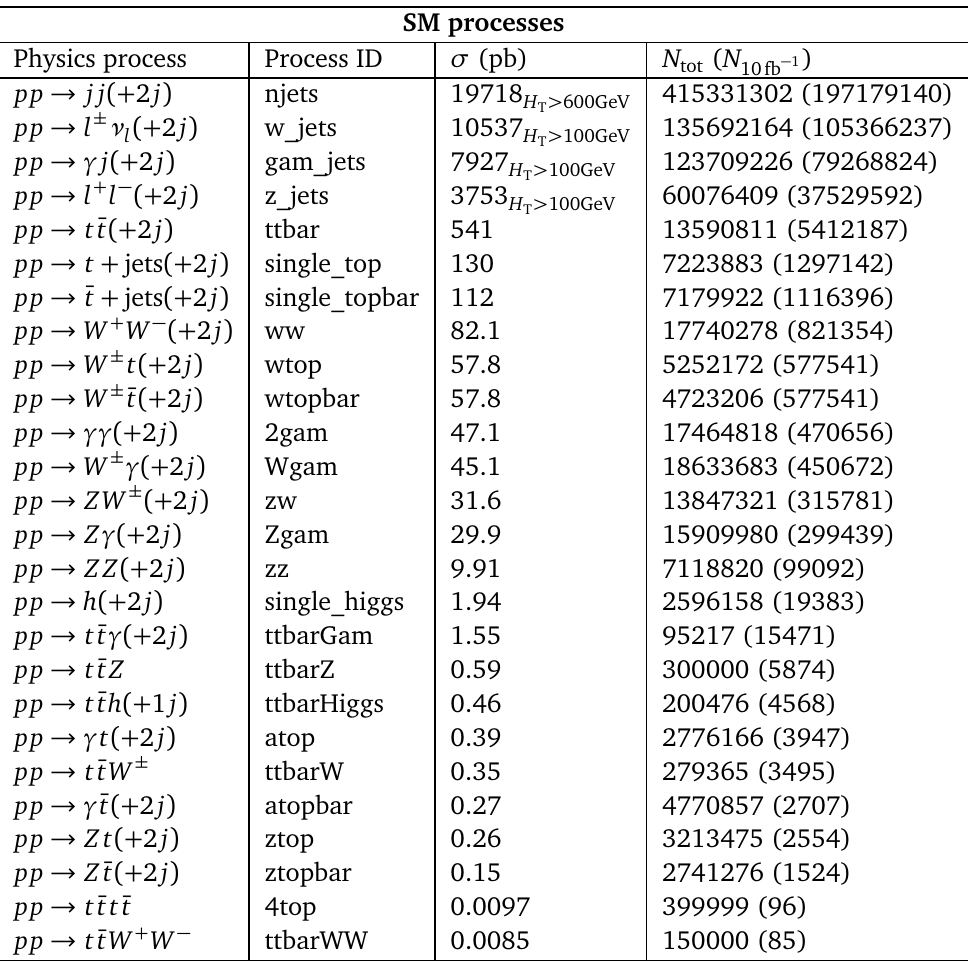
Table 2: Generated background processes (first column) with the corresponding identification (second column), the LO cross section σ in pb (third column) and the total number of generated events N (fourth column). In the last column, we tot also indicate the number of events corresponding to 10 fb − 1 of data ( N 10fb − 1